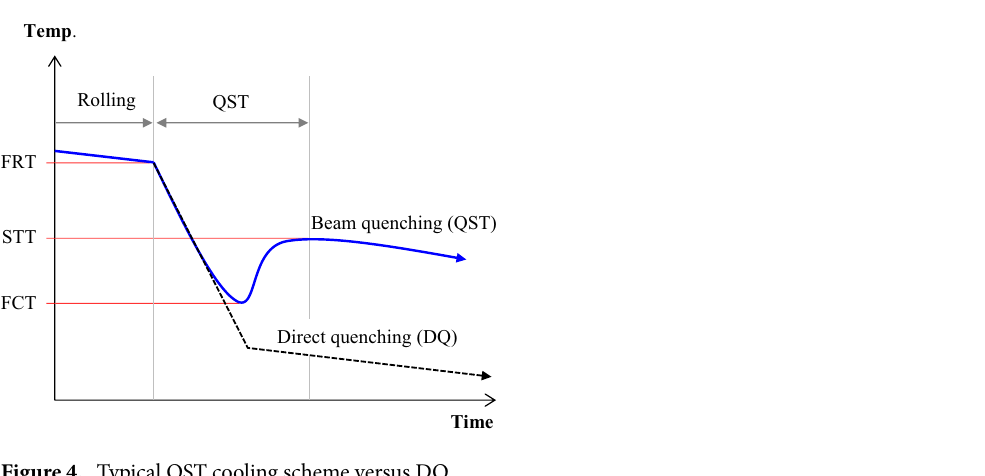
Figure 4. Typical QST cooling scheme versus